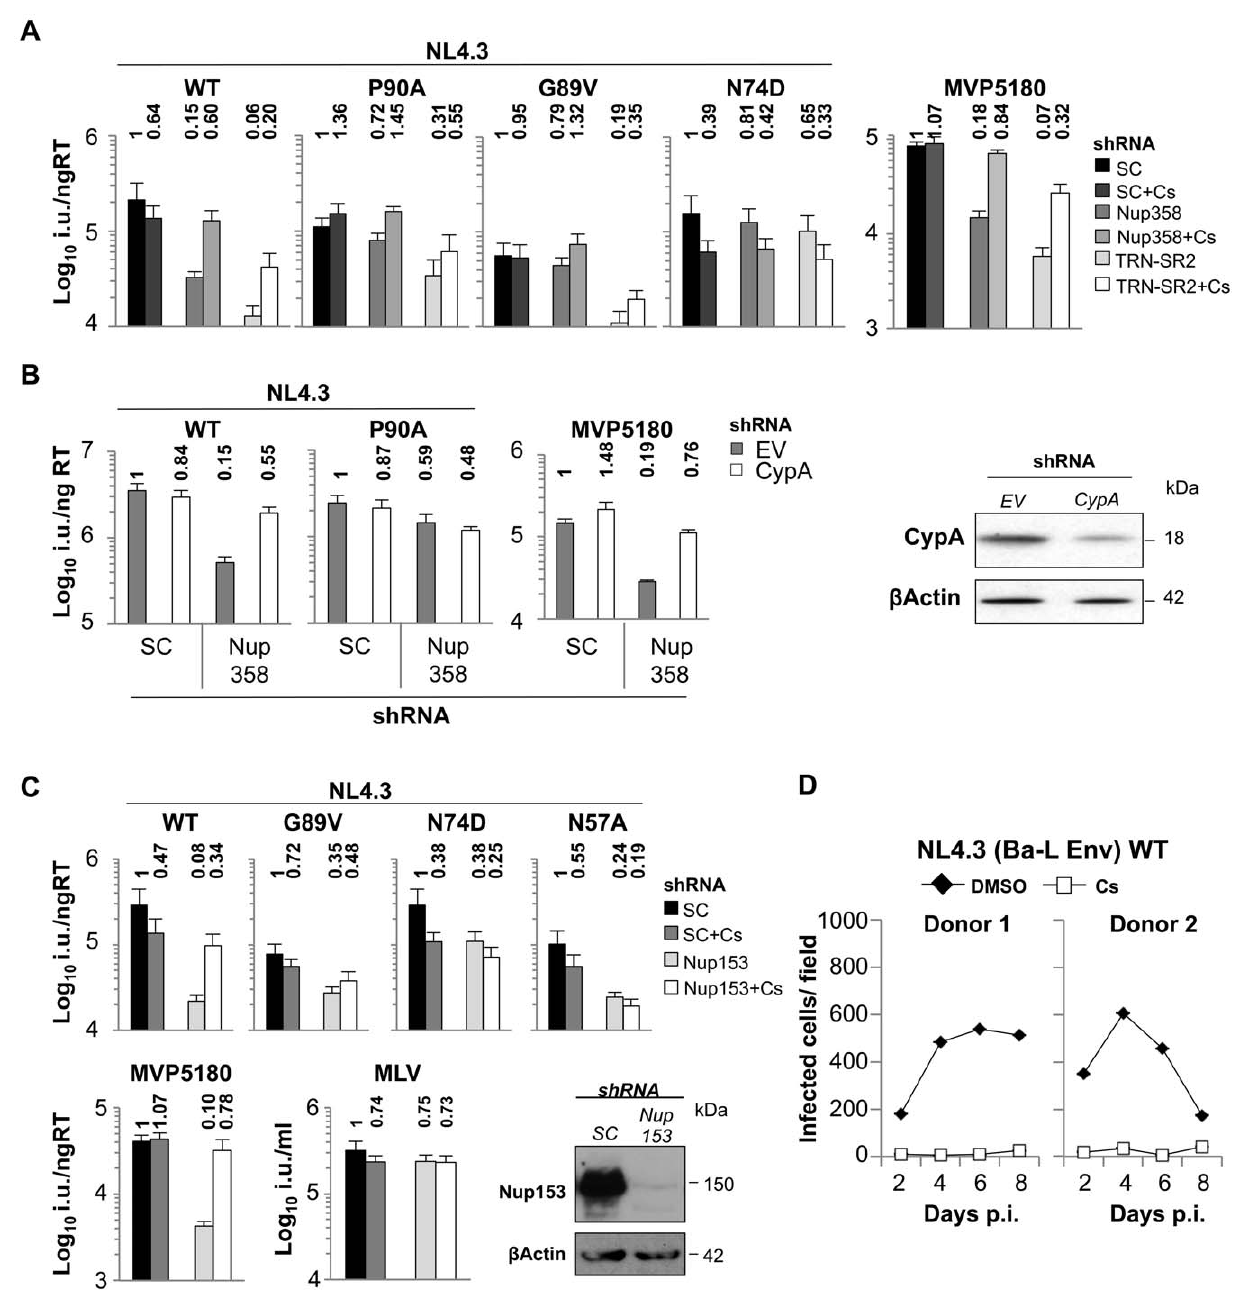
Figure 6. CypA inhibition forces HIV-1 into a Nup358/Nup153 independent nuclear entry pathway. A , Titers of VSV-G pseudotyped NL4.3 HIV-1 GFP vectors bearing wild type or mutant CA on HeLa control cells (SC), or Nup358 or TRN-SR2 depleted cells in the presence or absence of 8 m M Cs (mean and SD, n=3). Relative changes from titer on control cells are shown above the bars. B , HeLa cells expressing scrambled control (SC), or Nup358 specific shRNA were transiently transduced with either MLV empty vector control or vector expressing CypA specific shRNA